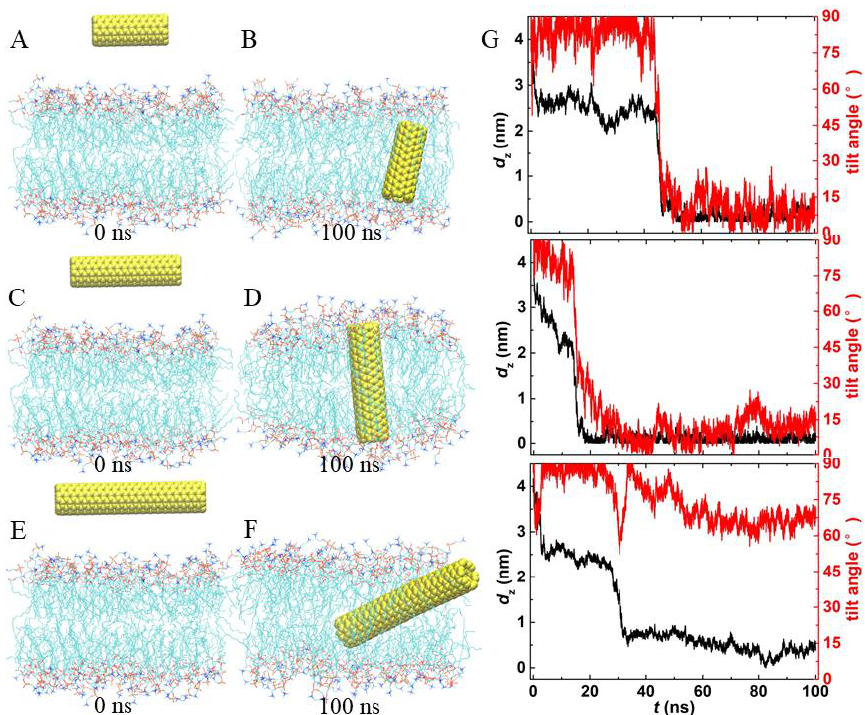
Figure 3. Trajectories of PCNTs with different lengths entering the membrane. ( A – F ) The initial and final snapshots of each system. Water is not shown for clarity. ( G ) Time evolutions of the COM distance in the z -direction and the tilt angles of each system.